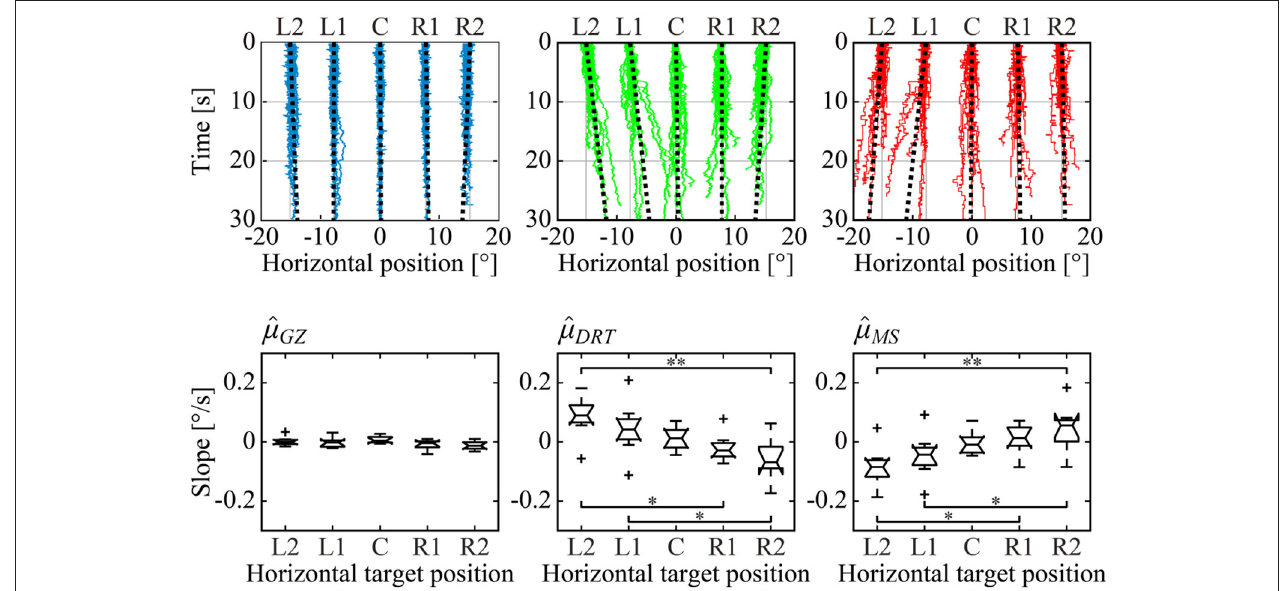
FIGURE 4 | Horizontal dependence of the target position on GZ, DRT, and MS time series and the slopes on their trend. Upper panels: All sample paths of GZ (left, blue), DRT (middle, green), and MS (right, red) time series of a representative subject were superimposed for each of the five target positions. Black dotted lines are the least-squares linear regression lines, representing the linear trend of the time series for each of the five target positions. Lower panels: box plots of the mean value of the subject-wise means of slopes for each time series across all subjects. Single and double asterisks indicate that there was a significant difference between groups at the 5 and 1% significance level,